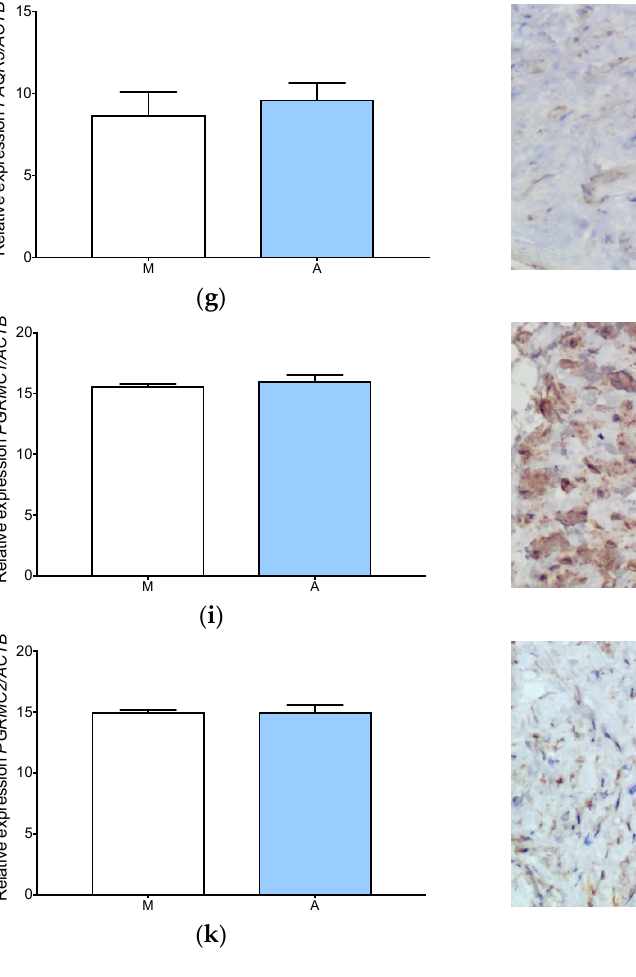
Figure 1. Progesterone receptors expression in adenomyosis and normal myometrium. Characterization of PGR expression at gene ( a ) and protein ( b ) level, PAQR7 gene ( c ) and protein ( d ) level, PAQR8 gene ( e ) and protein ( f ) level, PAQR5, gene ( g ) and protein ( h ) level, PGRMC1 gene ( i ) and protein ( j ) level and PGRMC2 gene ( k ) and protein ( l ) level. The columns represent the ratio of the expression of the gene tested and ACTB ± SEM. Asterisk indicates significant differences (* p ≤ 0.05). Original magnification, 40×; scale bar, 50 µm. A, adenomyosis; M, myometrium. Immunohistochemistry analysis confirmed the presence of all the progesterone